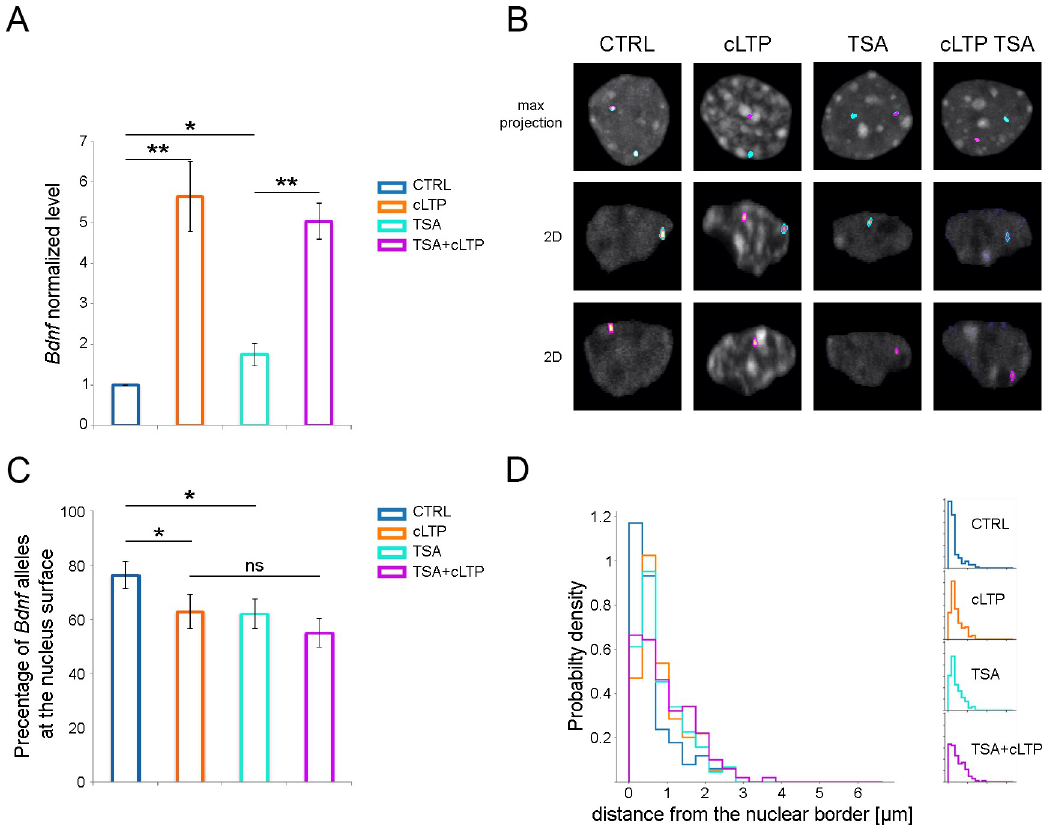
Fig 4. The inhibition of histone deacetylases induces Bdnf transcription and repositioning independently from the neuronal stimulation. (A) The graph shows the expression of Bdnf normalized to control in the hippocampal neurons incubated for 2 hours with DMSO vehicle (CTRL, blue bar) or picrotoxin, forskolin, and rolipram (cLTP, orange bar), incubated for 12 hours with TSA and 2 hours with DMSO (TSA, cyan bar) or picrotoxin, forskolin, and rolipram (TSA+cLTP, magenta bar). Kruskal-Wallis group comparison p < 0.01, and the One-Sample T-test or Welch Two Sample t-test for pairwise comparison: � p < 0.05, �� p < 0.01, ��� p < 0.001; error bars indicate standard error of the mean for 5 independent experiments (B) Representative pictures of the nuclei of hippocampal neurons treated as described above. Hoechst 3342 staining for chromatin is shown in greyscale and segmentation of FISH signals for the Bdnf gene are shown in magenta and cyan. (C) Percentages of nuclei with the minimum distance between the respective alleles and nucleus surface < 350 nm are shown (Chi-square test, all groups, p < 0.01; Fisher’s exact tests � p < 0.05, ��� p < 0.001, error bars indicate standard deviation of the binomial distribution). (D) Quantitative analysis of the intracellular positions of Bdnf alleles in the nuclei of hippocampal neurons treated and color-coded as in A. The minimal distance between the respective alleles and nucleus surface is presented in the normalized histogram.